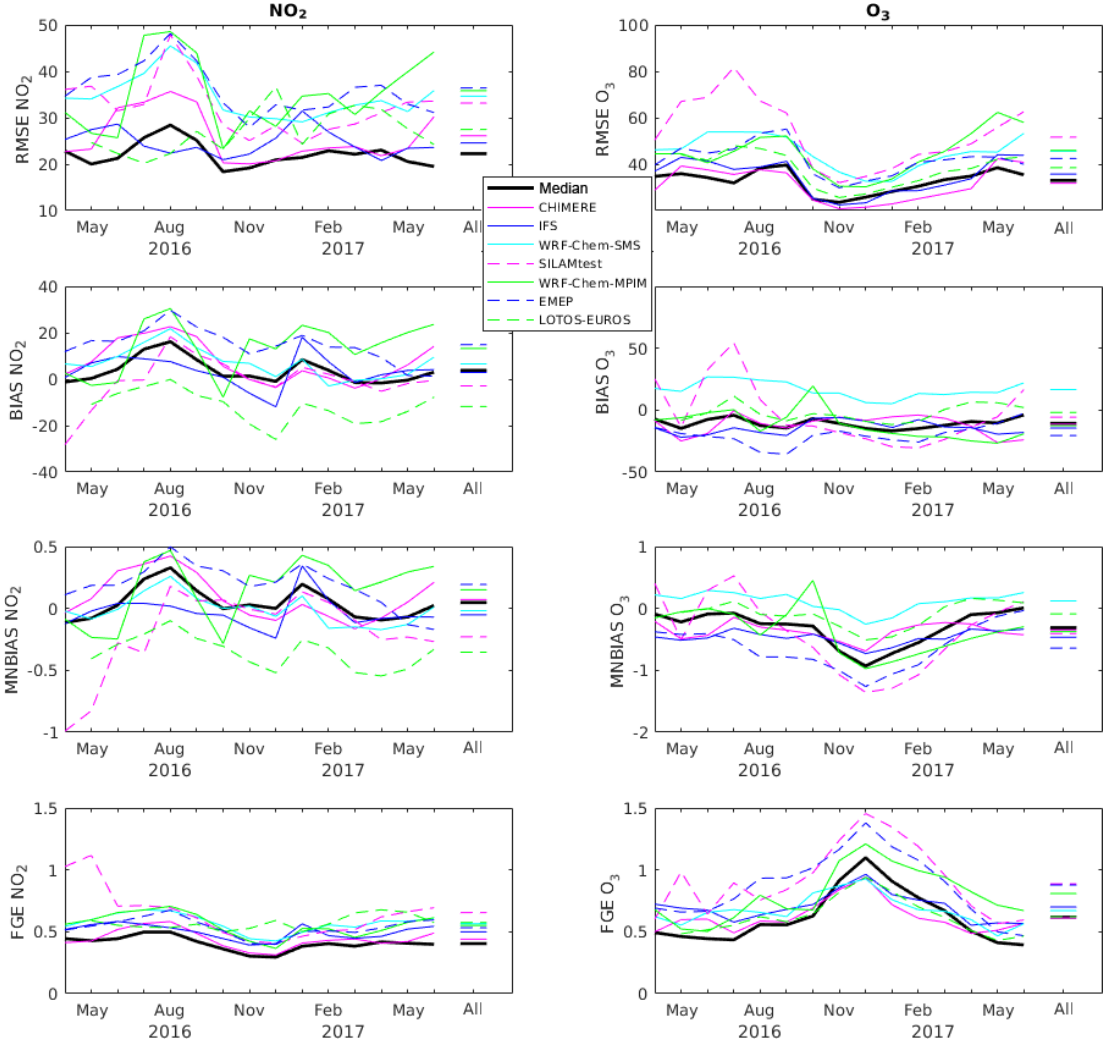
Figure 2. RMSE (in µgm − 3 ), BIAS (in µgm − 3 ), MNBIAS, and FGE of NO 2 and O 3 for each month and for the entire time period (April 2016–June 2017 and lines on the right side of each